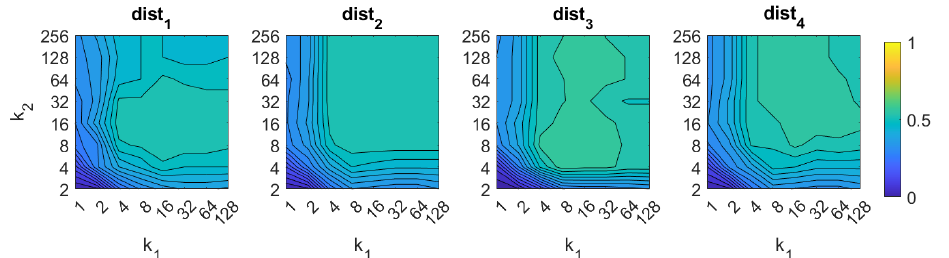
Figure 6. FS image retrieval problem. Success rate of the method. k 1 and k 2 are, respectively, the number of rows and columns of the descriptor (Table 1).